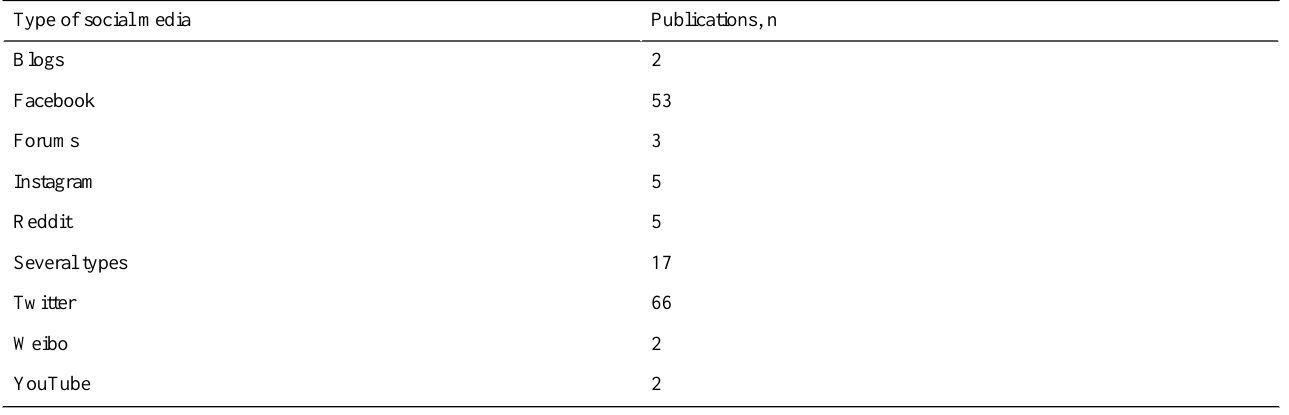
Table 4. Distribution of publications by social media (N=155).